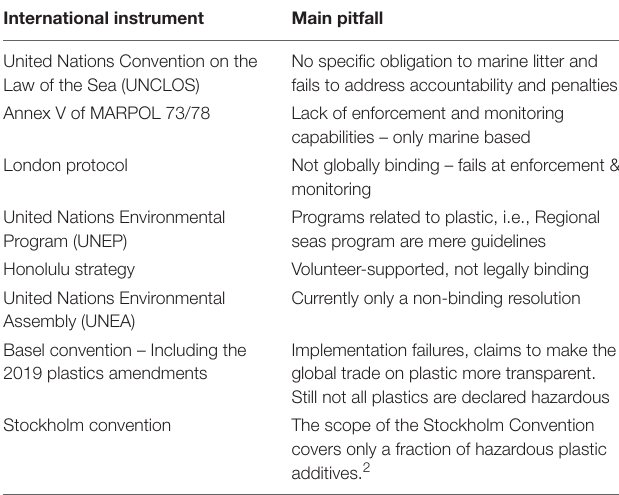
TABLE 3 | Current international instruments related to Marine Plastic Pollution and their